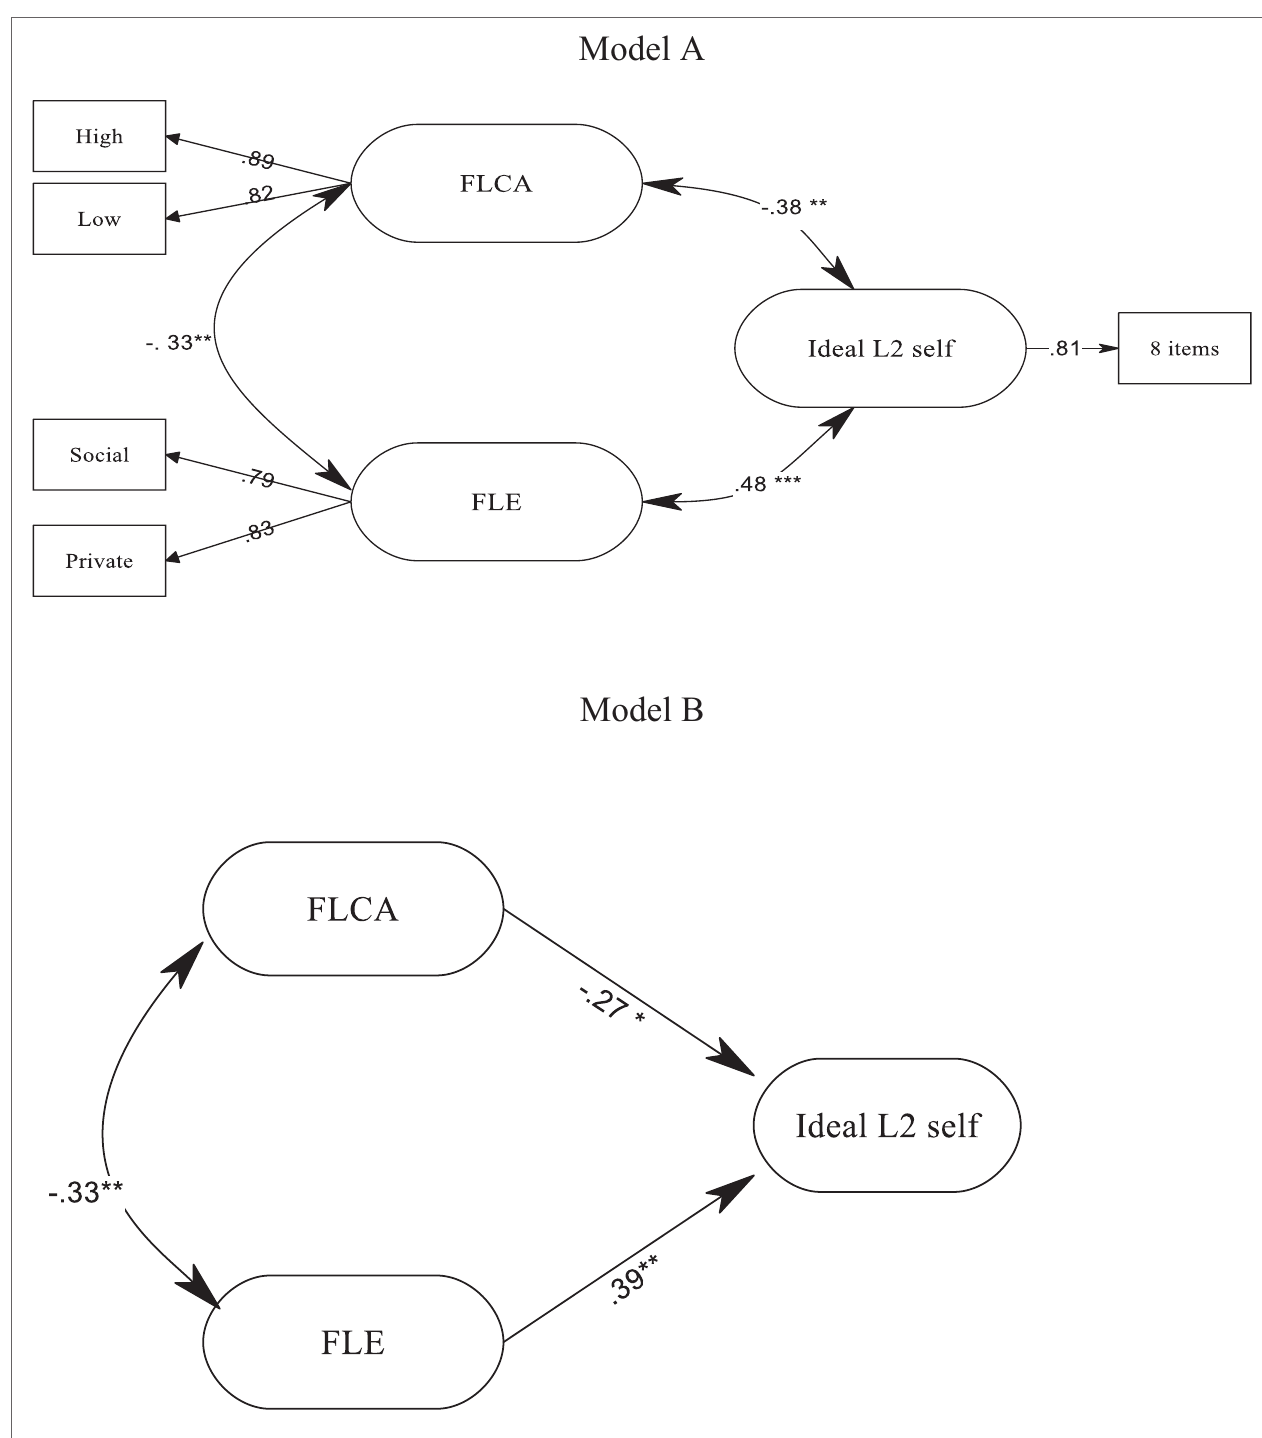
FIGURE 1 | Foreign language classroom anxiety (FLCA) and foreign language enjoyment (FLE) as predictors of ideal L2 self. * p < 0.05, ** p < 0.01, and *** p <